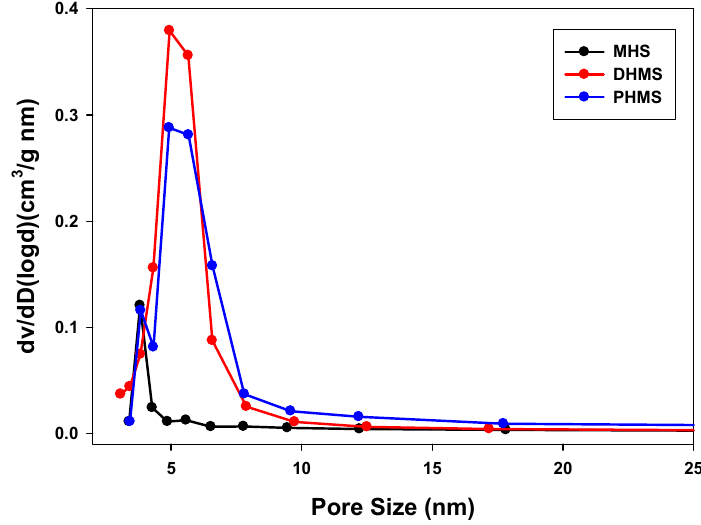
Figure 3. Pore size distribution of MHS, PMHS, and DMHS. Table 1. The textural properties of the MHS, PHMS, and DMHS. Sample